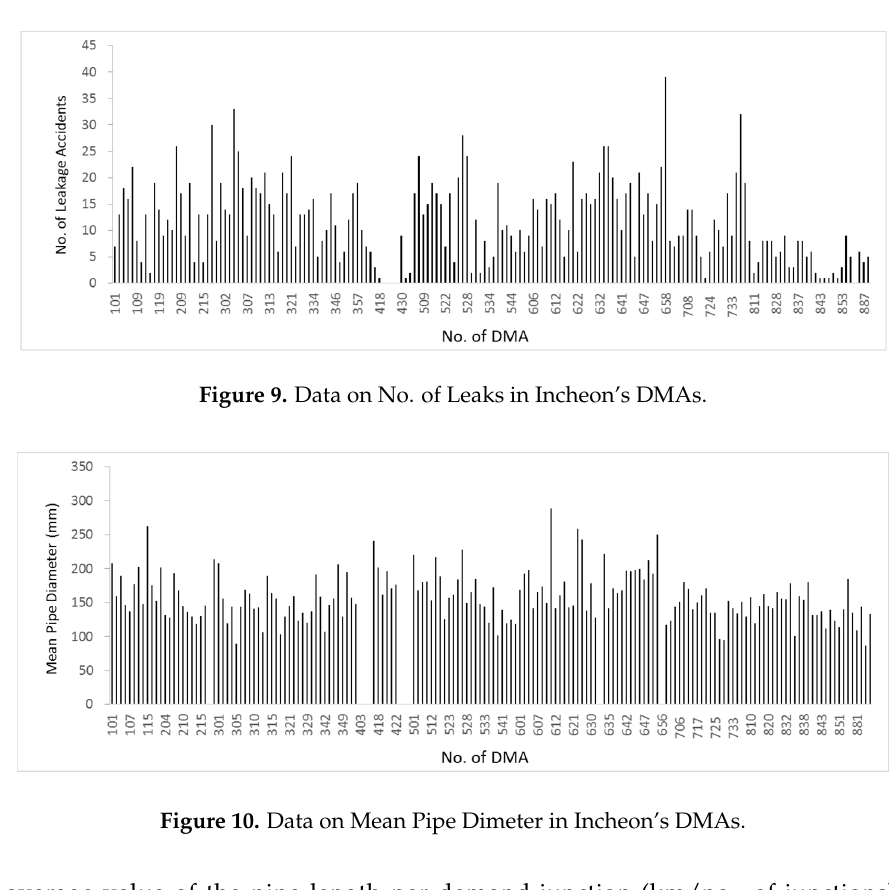
Figure 8. Data on Demand Energy Ratio in Incheon’s DMAs.